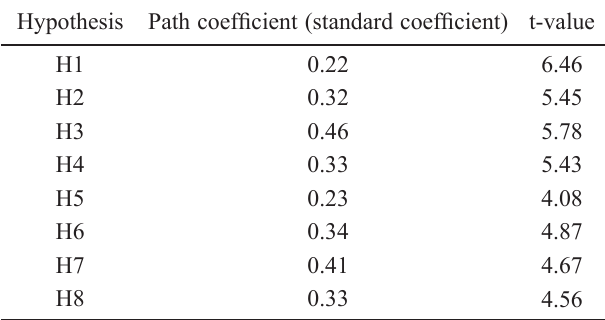
Table 3. Path coefficient for the